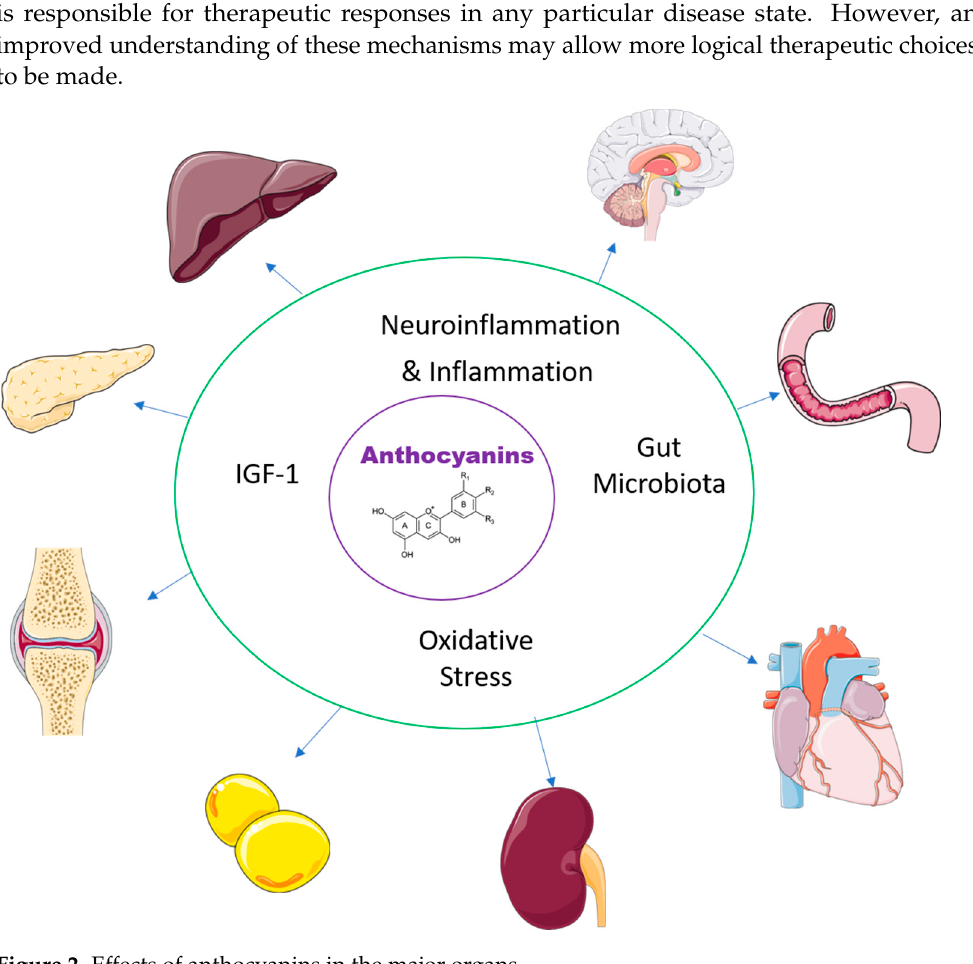
Figure 2. Effects of anthocyanins in the major organs.